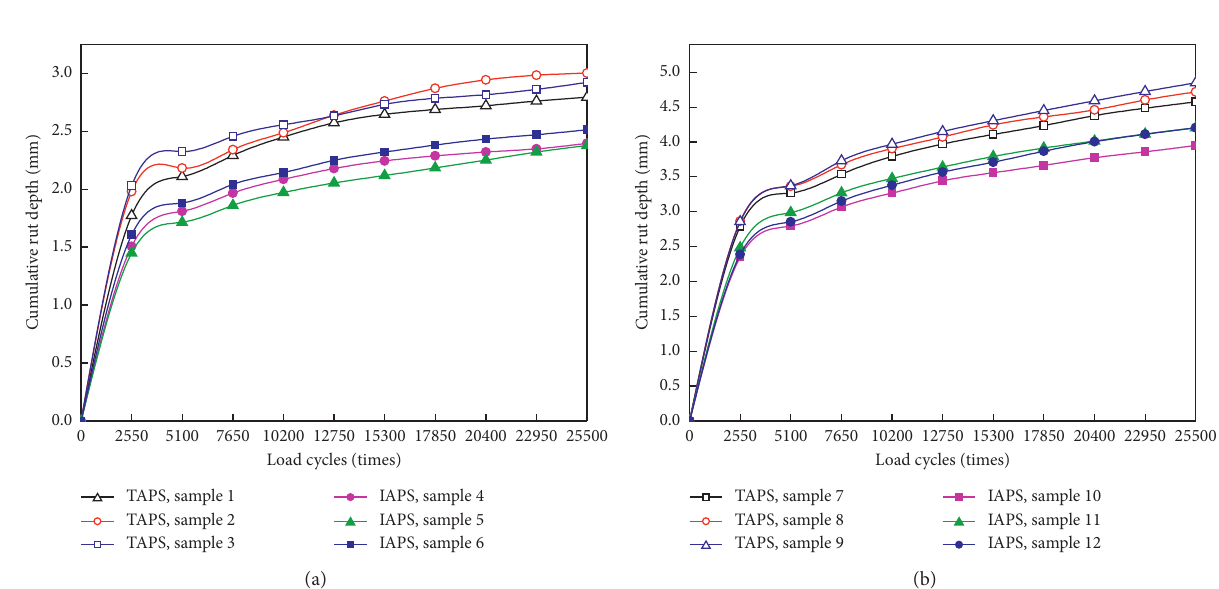
Figure 7: Cumulative rut depth trend with the number of loading cycles: (a) wheel load � 0.7 MPa and (b) wheel load �